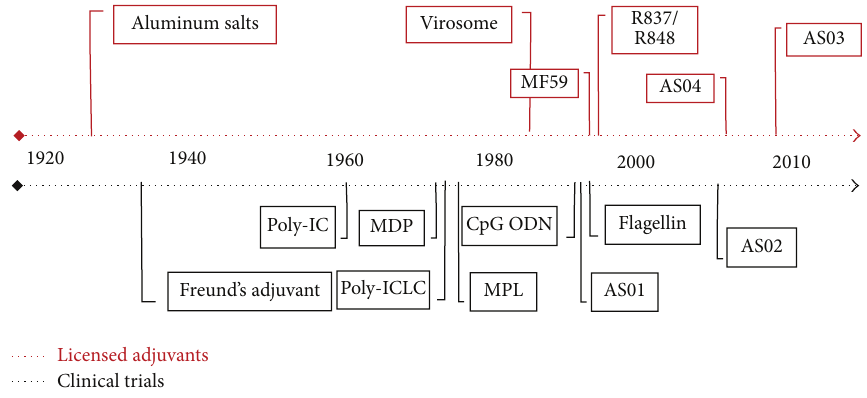
Figure 1: Timeline of vaccine adjuvants discovery.